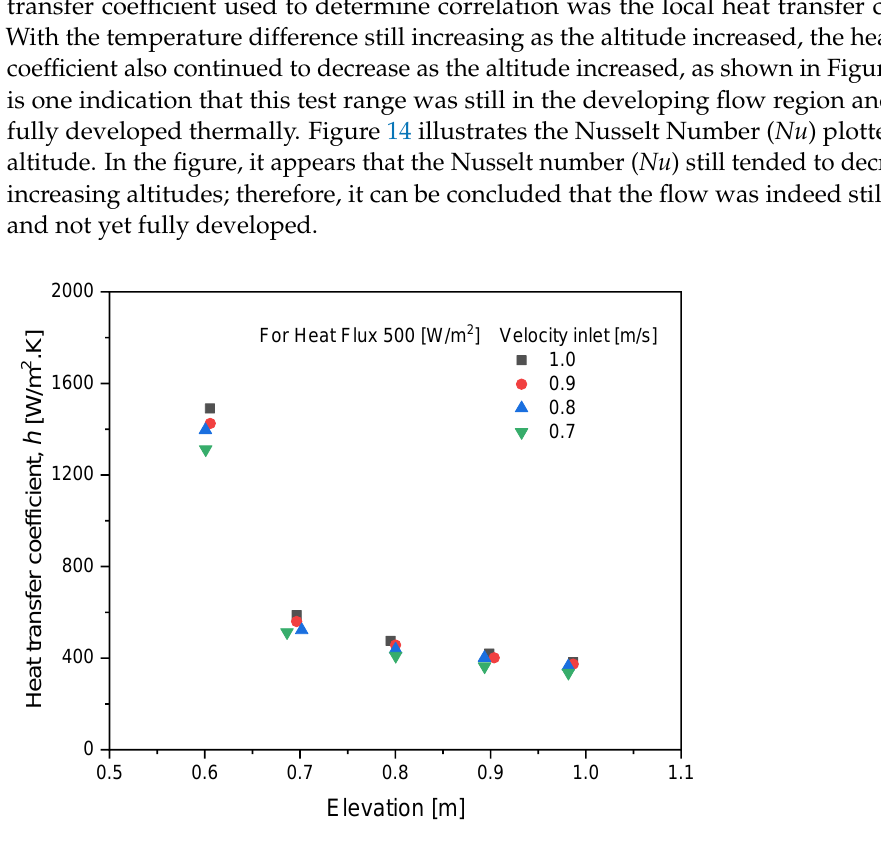
Figure 13. Heat transfer coefficient for laminar flow with variation of flow velocity at forced convection inlet with heat flux of 500 W/m 2 .